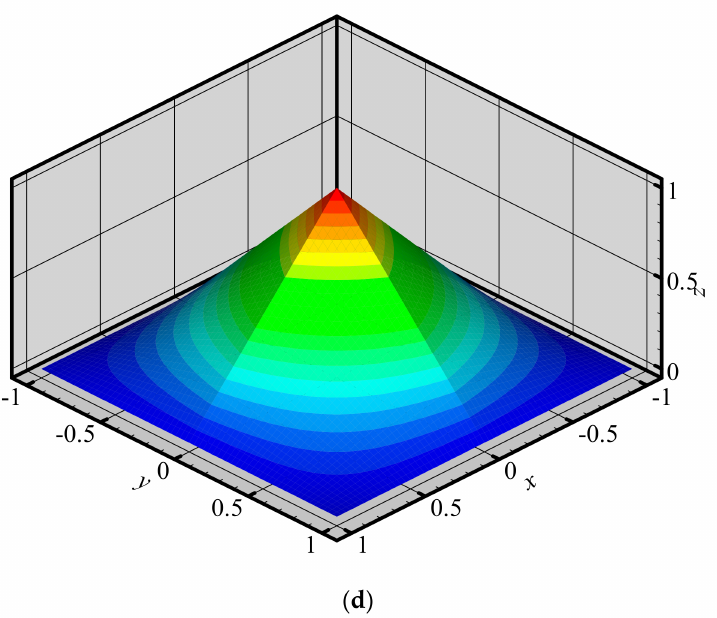
Figure 5. Shape functions of QUAD4 element for different nodes at different locations. ( a ) node 1; ( b ) node 2; ( c ) node 3; ( d ) node